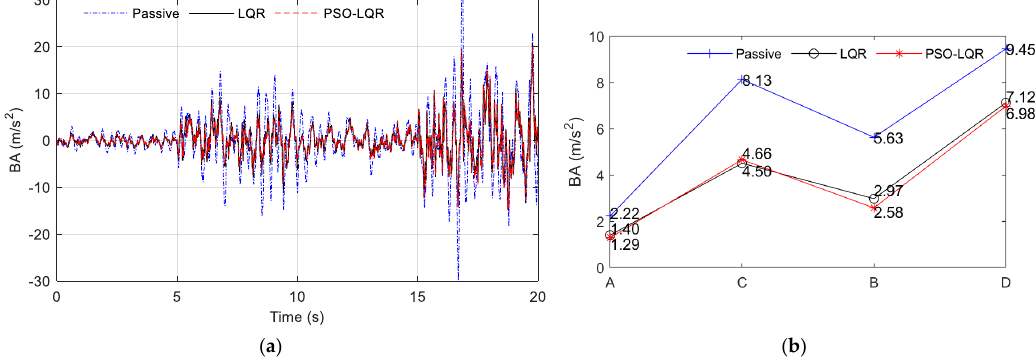
Figure 16. BA comparison diagram of mode switching on the changed road surface. (a) Time domain variation curve of A–C–B–D road section. (b) RMS value of A–C–B–D road section.